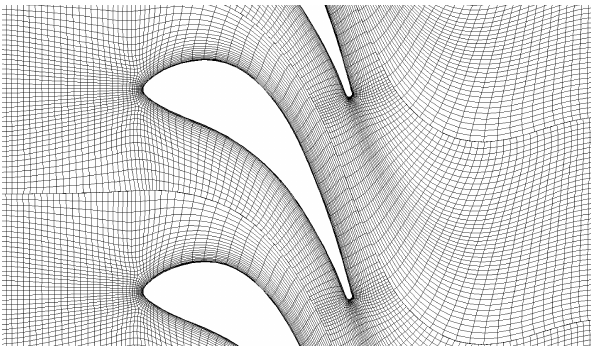
Figure 5. Computation grid of VKI